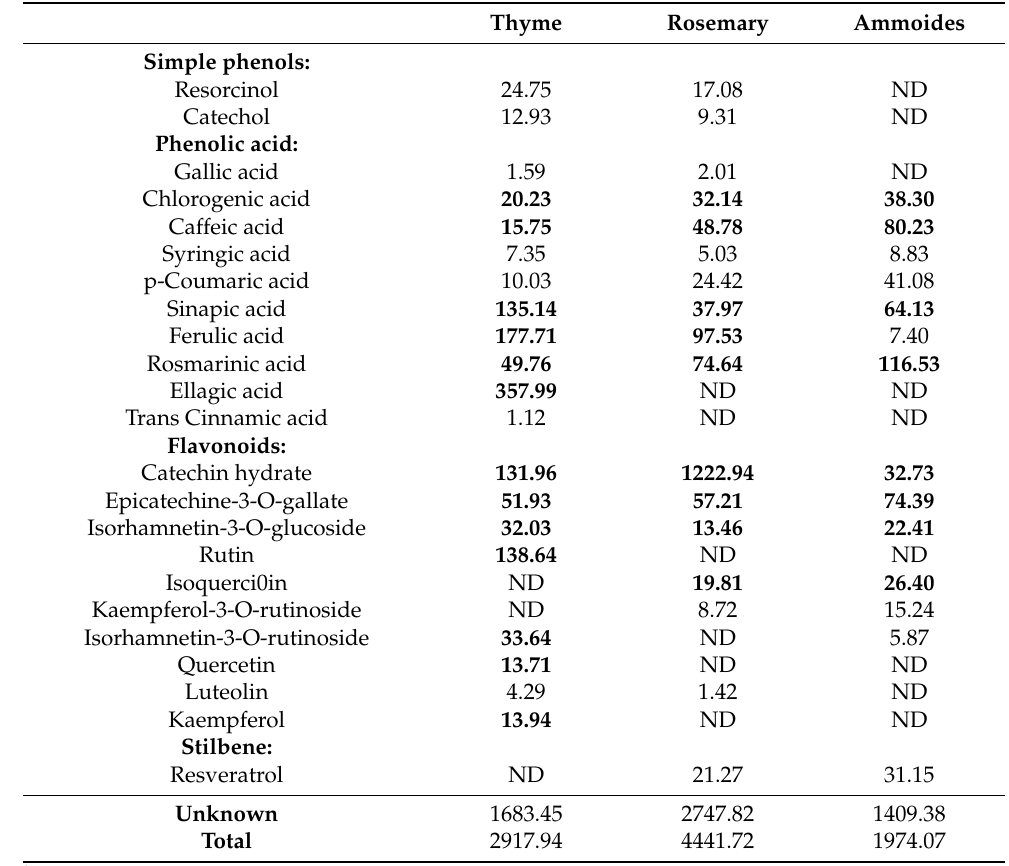
Table 2. Polyphenol profile of aqueous extracts of thyme, rosemary, and ammoides (mg/100 gExtract) 1 .